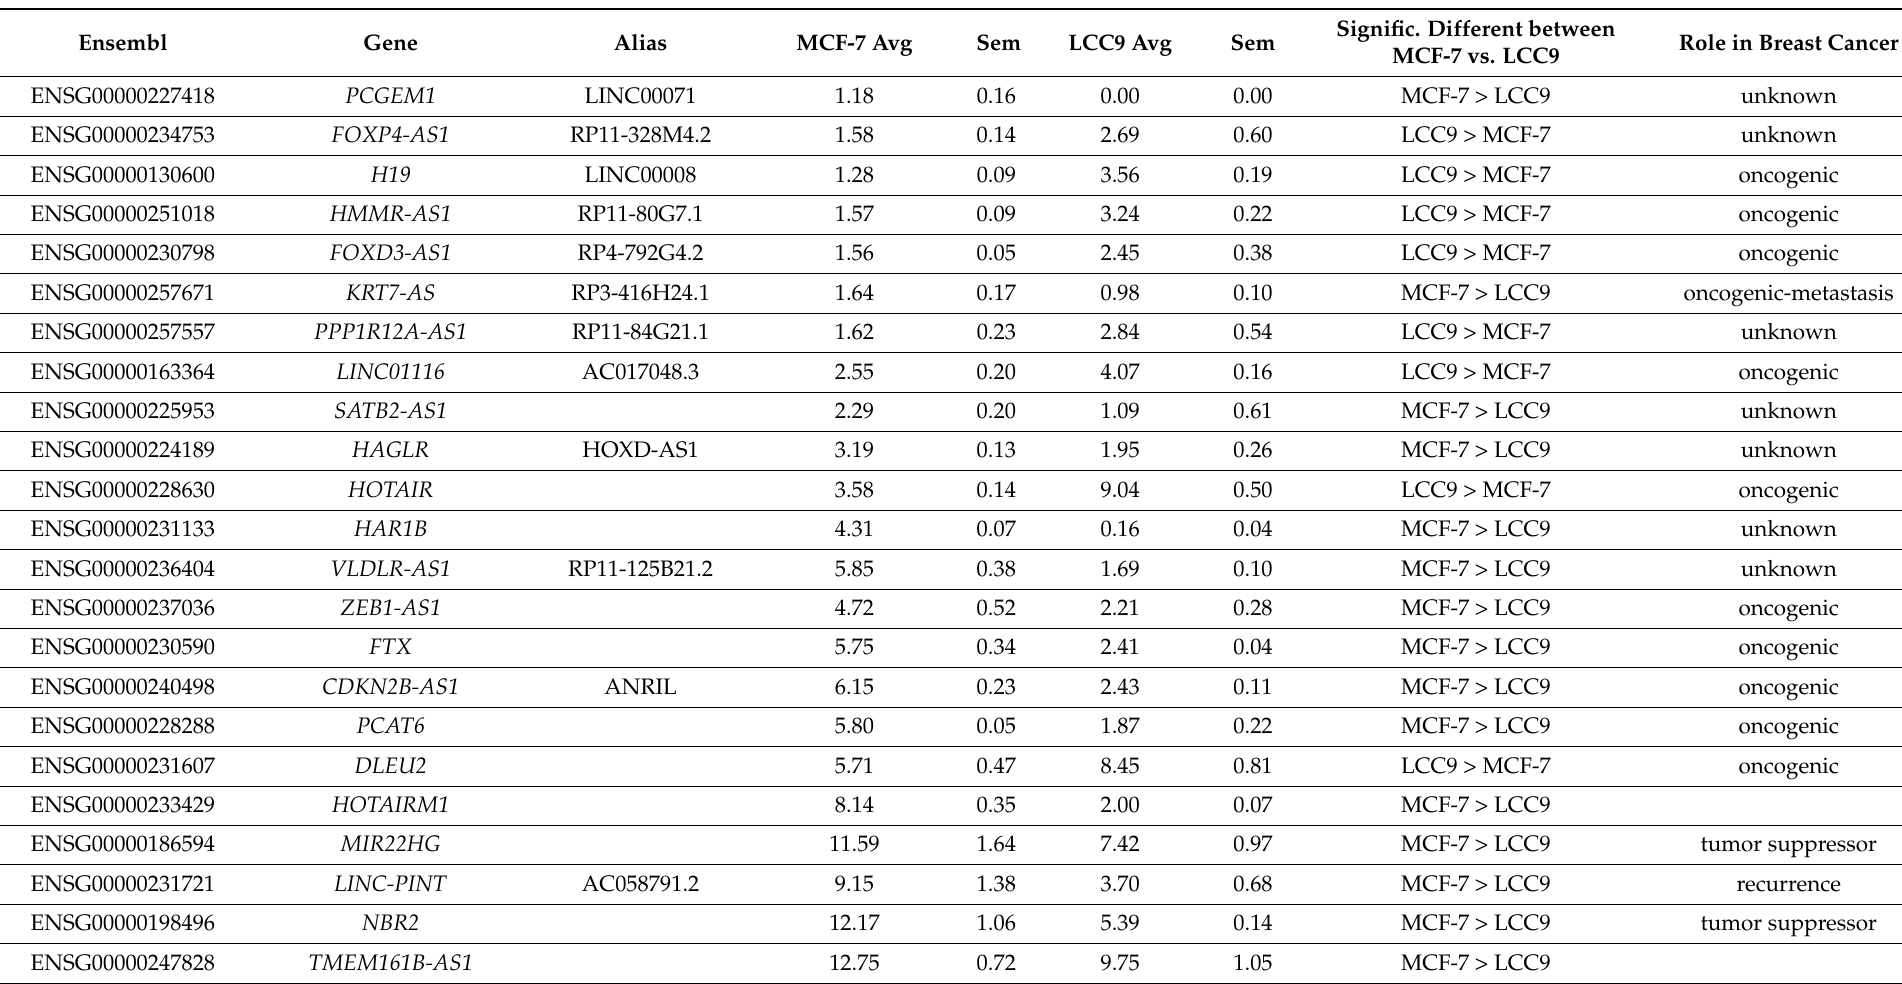
Table 3. lncRNAs differentially expressed in MCF-7 and LCC9 breast cancer cells that are not regulated by miR-29b-1/a. Values (FPKM) are the average of five replicates.